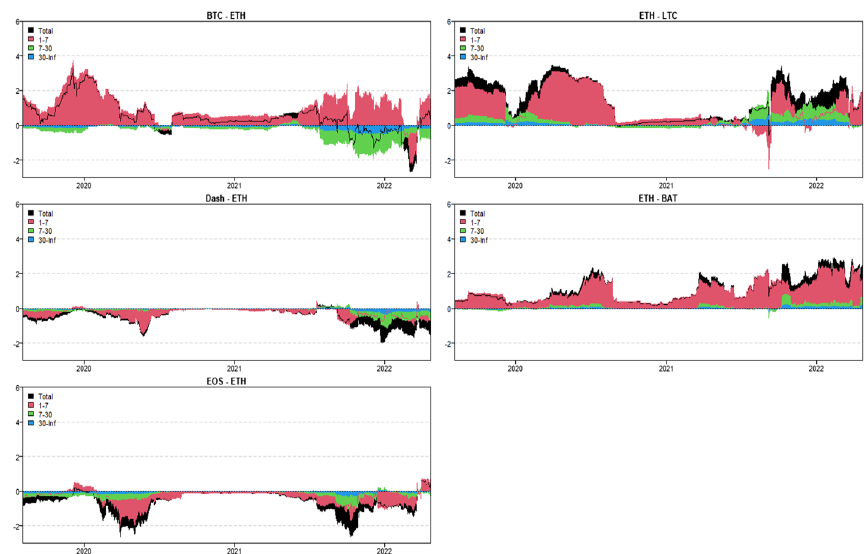
Fig. 16 Dynamic net-pairwise connectedness—realized skewness (RS)-ETH